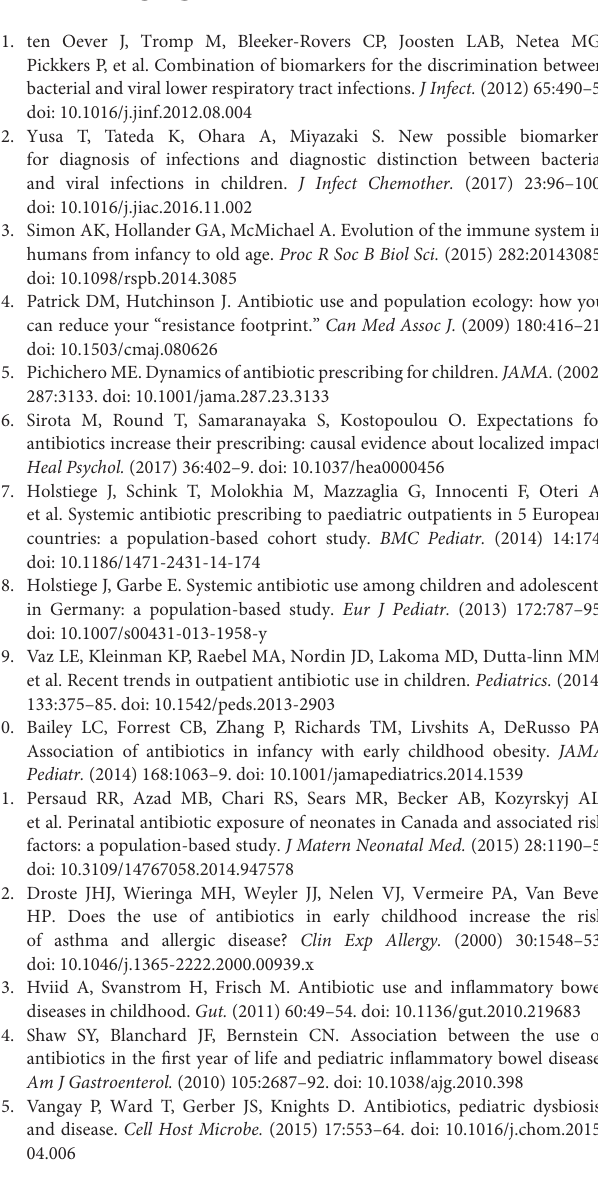
Supplementary Table 1 | PBMC immune cell subset staining panels for flow cytometric analysis. Supplementary Table 2 | Primers used for qPCR gene expression of RNA extracted from whole blood. Supplementary Table 3 | In vitro cytokine secretion from PHA stimulated PBMCs between AB and PL piglets on PND 21 and 49 1 . 1 Data present as mean ± pooled SEM. Data was analyzed using a Two-way ANOVA. AB, antibiotic; PL, placebo; PHA, phytohaemagglutinin; PBMC, peripheral blood mononuclear cell; PND, post-natal day; SEM, pooled standard error of the mean. PND 21: AB n = 7, PL n = 7; PND 49: AB n = 7, PL n = 8.